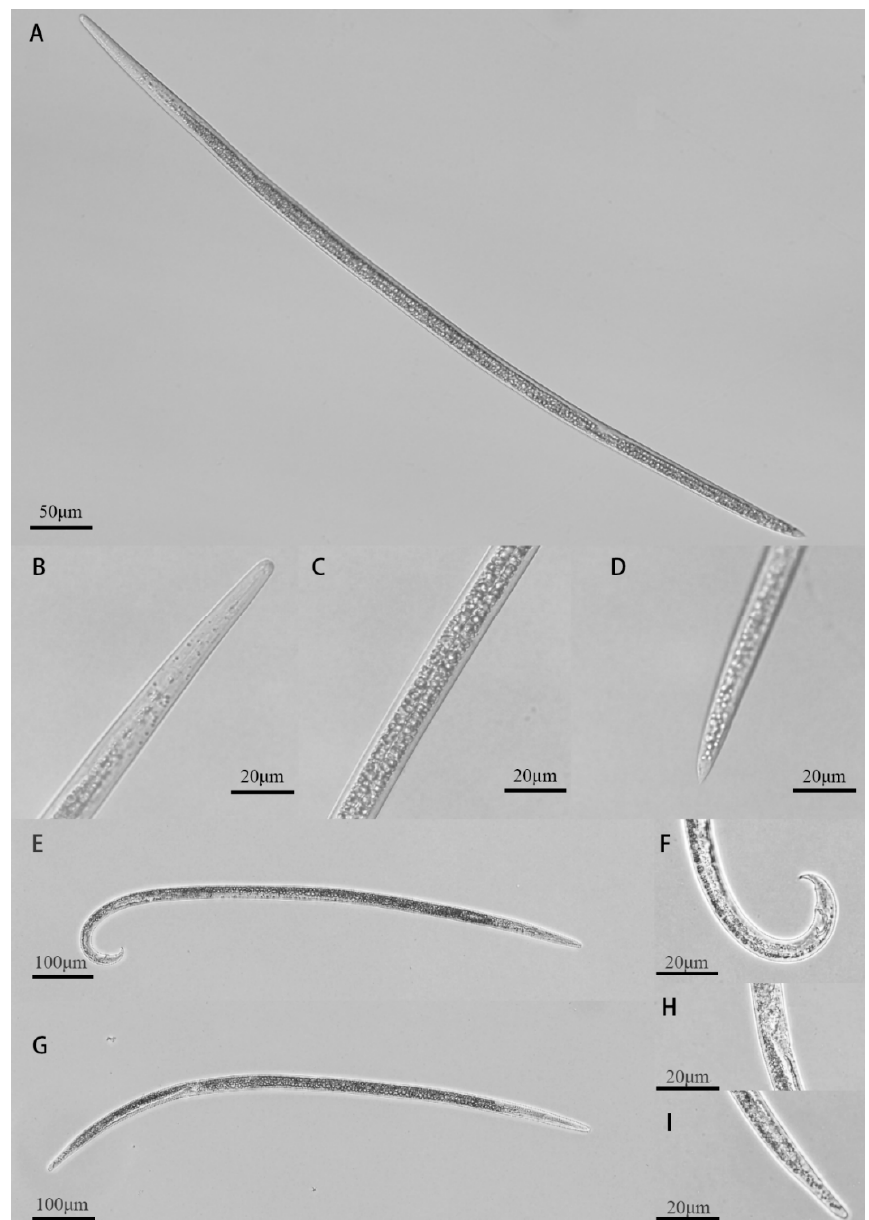
Figure 2. Morphological characteristics of Bursaphelenchus xylophilus isolated from M. saltuarius. ( A – D ) fourth-stage dispersal juveniles of B. xylophilus ; ( E – I ) adult B. xylophilus .